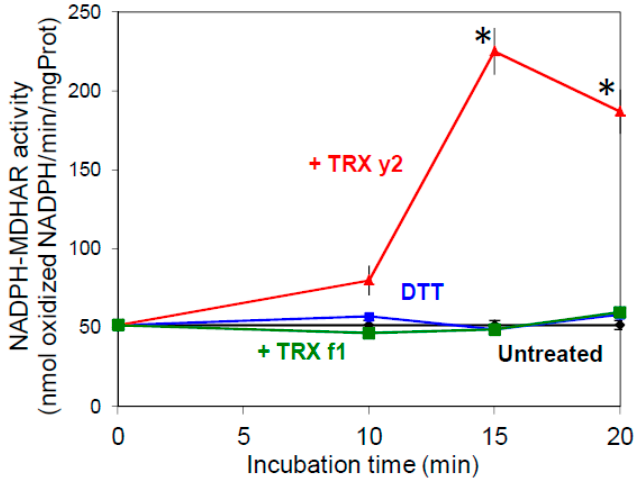
Figure 7. Effect of TRX on NADPH-dependent MDA reductase (MDHAR) activity in leaf extracts. Col-0 leaf protein extracts were incubated at room temperature in absence (black), or in presence of DTT, alone (blue), or with 20 µM TRX y2 (red), or TRX f1 (green) prior measuring NADPH-MDHAR activity. Data correspond to means ± SD ( n = 4, from 2 independent experiments). Mutant samples significantly different from untreated ( p < 0.05) are indicated by an asterisk (*).